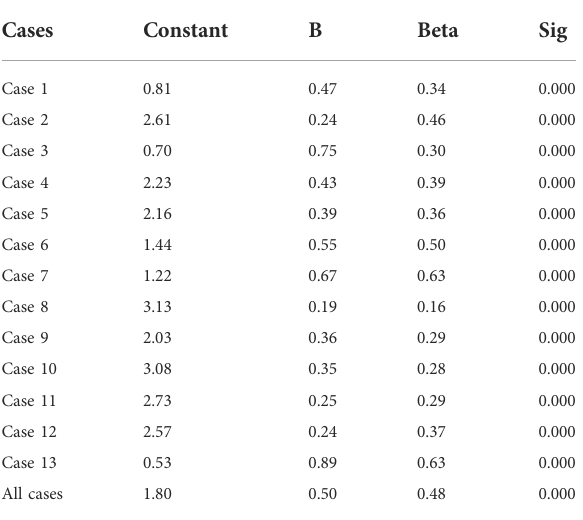
TABLE 9 Regression elements in all case study neighborhoods.